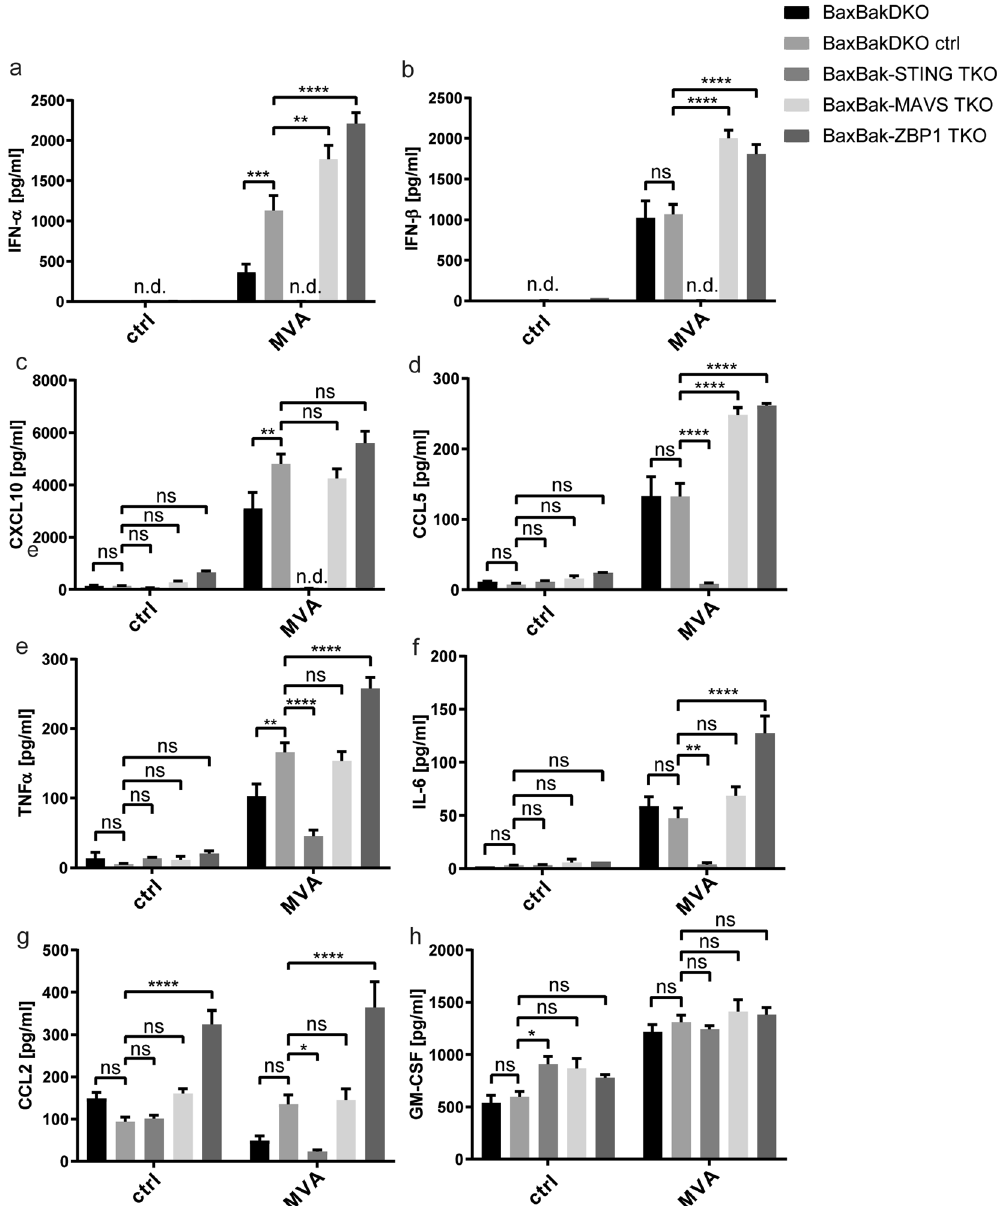
Fig. 7 In fl uence of DNA recognition pathways on macrophage activation. a – h Bax/Bak-STING TKO, Bax/Bak-MAVS TKO, or Bax/Bak-Zbp1 TKO cells (genetically modi fi ed by CRISPR/Cas) were infected with MVA at an MOI of 2 and supernatants were collected after 22 h. Samples were analysed for the cytokines indicated by a bead-based assay (Legendplex, antivirus response panel, Biolegend). Bax/BakDKO and Bax/Bak ctrl cells (expressing an irrelevant gRNA directed against EGFP) served as controls. Shown are the means/SEM of n = 3